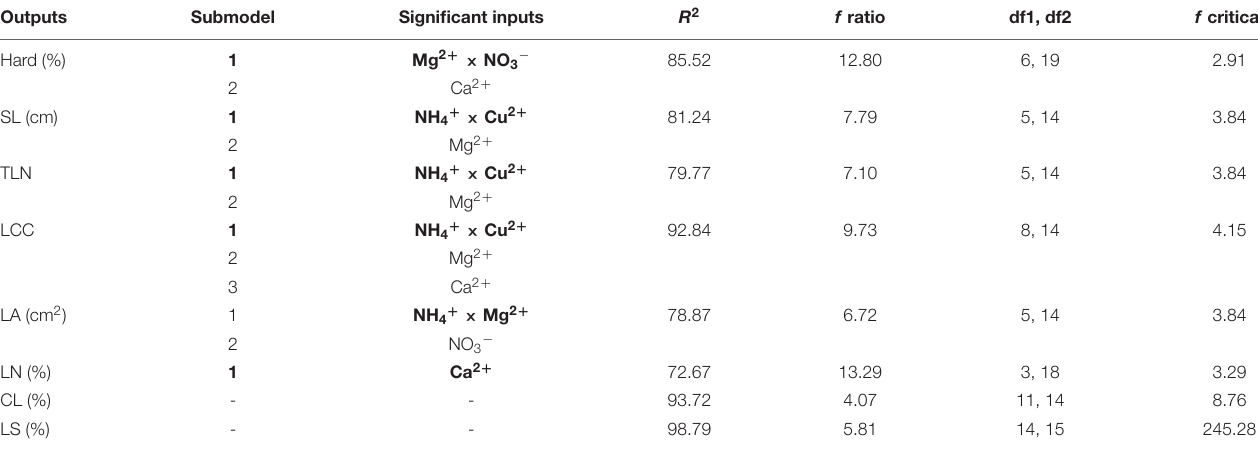
TABLE 4 | Neuro-fuzzy logic results for each output model. Outputs